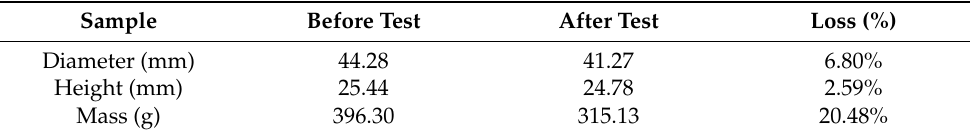
Figure 12. Anti ‐ wetting properties: Images in ( a ), ( b ) and ( c ) show different positions of the Mo ‐ block associated with the solidified Al ‐ Mg alloy to indicate the clean separation of Mo surface from the molten Al ‐ Mg alloy after ALCAN standard immersion test for 96 h. 3.3.3. SEM Analysis at the Mo/Al ‐ Mg Interface Higher ‐ resolution images by SEM analysis indicated that there were no intermediate Mo ‐ Al alloys at the interface between bulk Mo and the Al ‐ Mg alloy. Figure 13a shows the SEM image that reveals a lack of interaction between the bulk Mo and the Al ‐ Mg alloy. There is a close association between Al and Mg in the alloy matrix as indicated by the EDX elemental analysis provided in Figure 13b,c, respectively, while Figure 13d shows com ‐ plete segregation of Mo from the Al ‐ Mg alloy. The presence of oxygen on the part of the